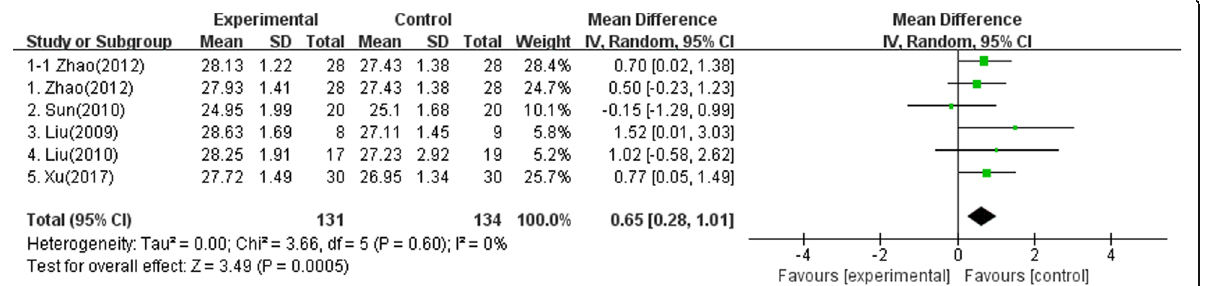
Fig. 4 Meta-analysis of MMSE of studies included (1 – 1: electroacupuncture and syndrome differentiation group vs. anti-dementia drugs group, 1 – 2: electroacupuncture alone group vs anti-dementia drugs group)